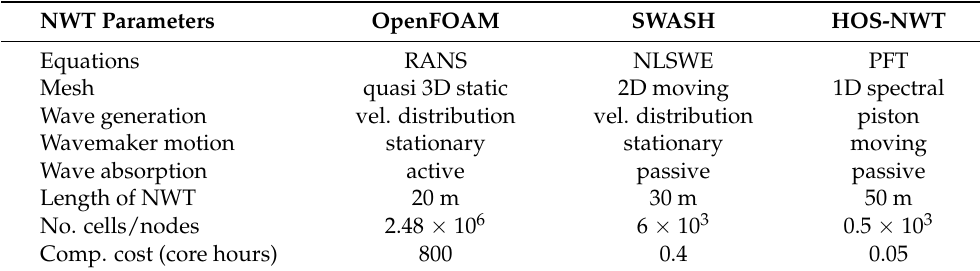
Table 4. Summary of the characteristics of the